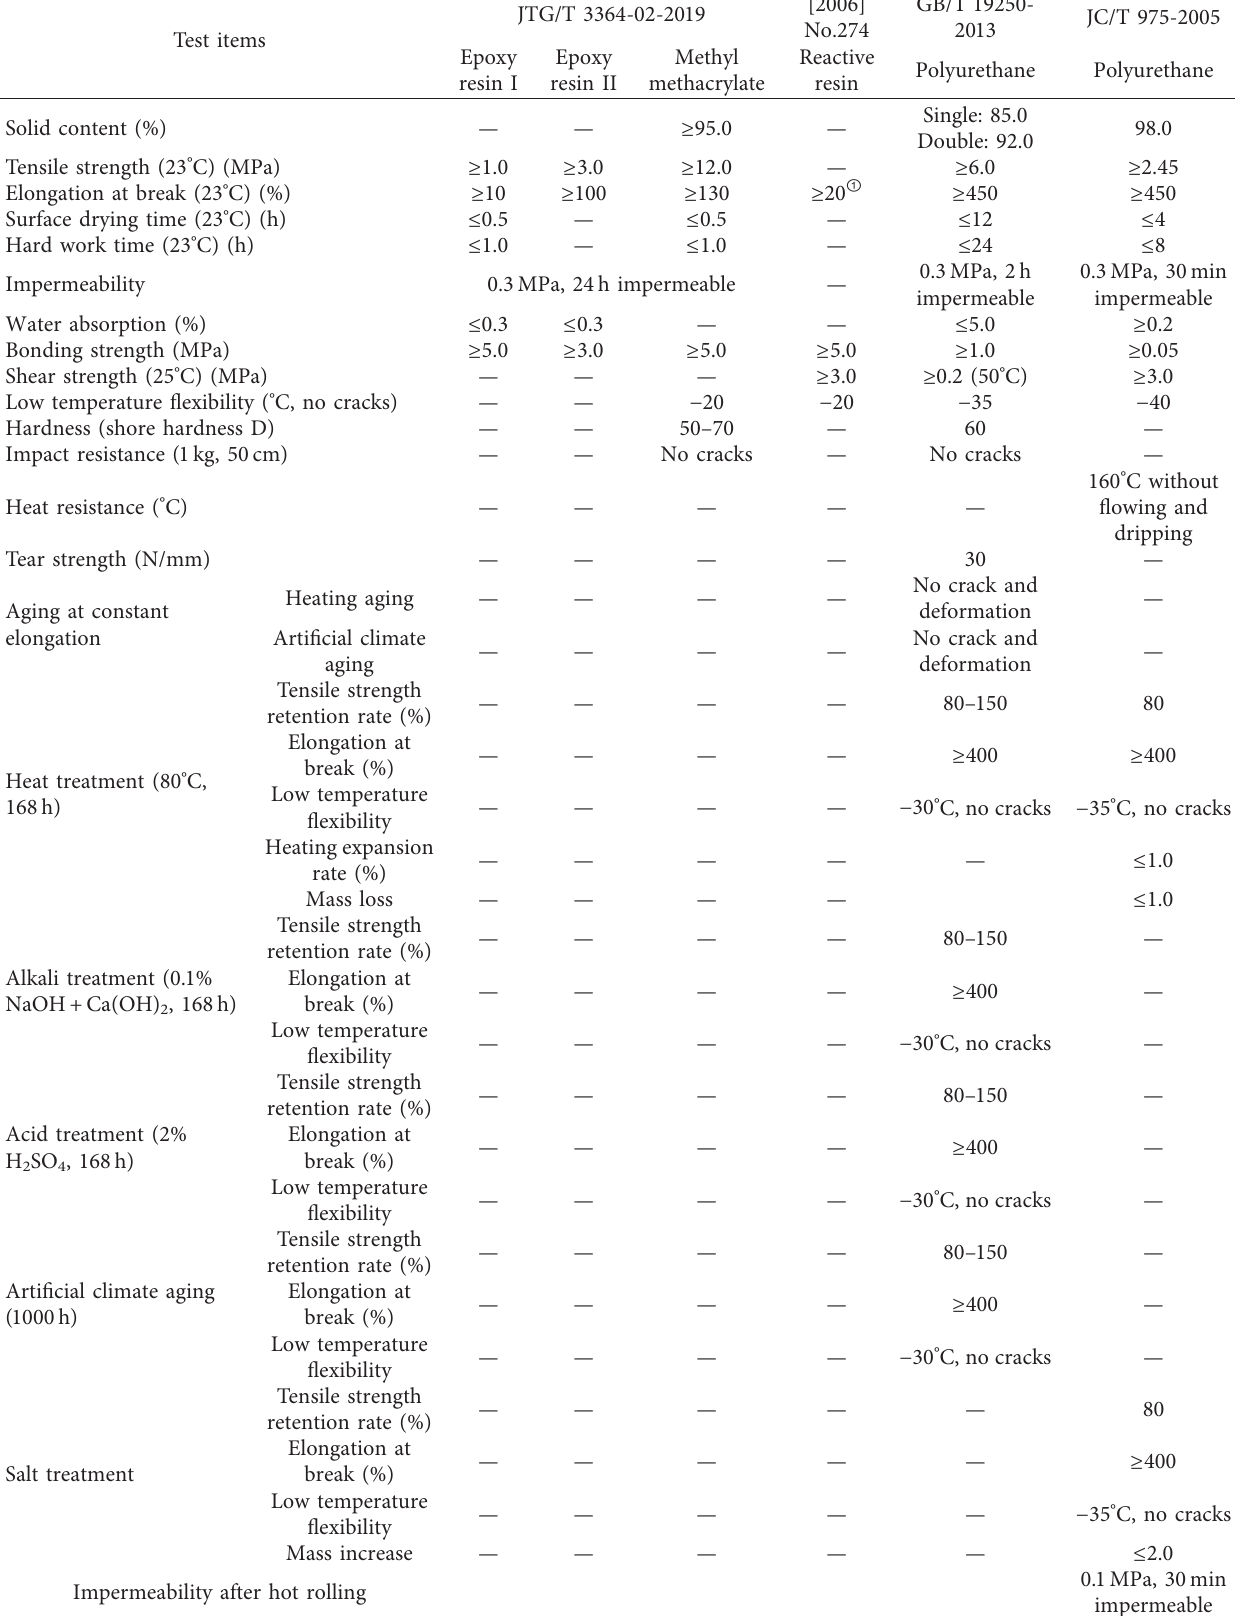
Table 1: Performance evaluation indicators and requirements of resin-based waterproof adhesive